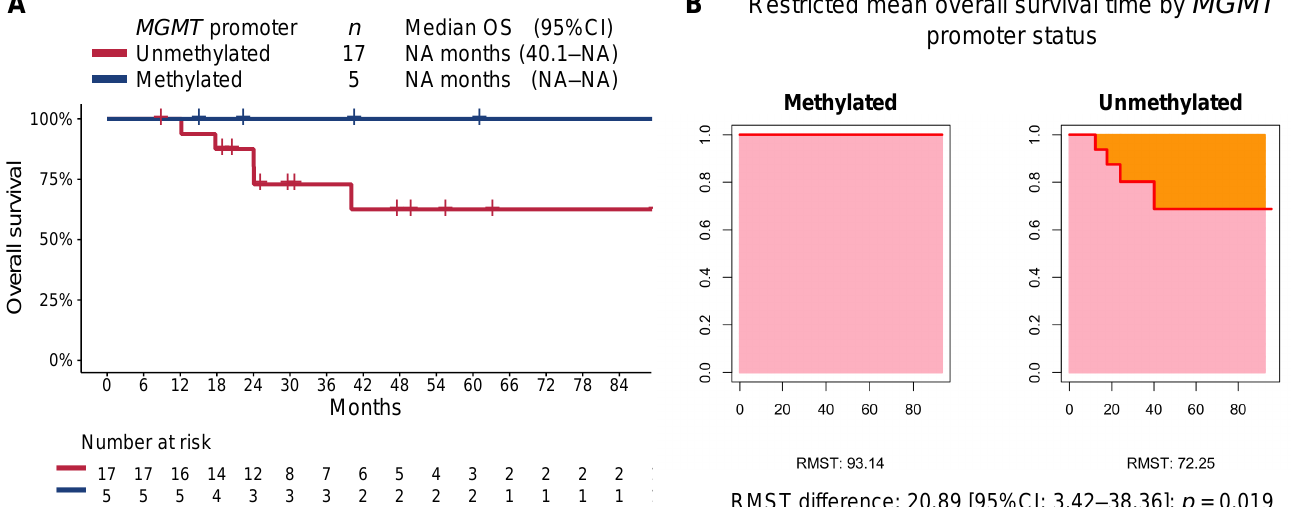
Figure 3. ( A ) Kaplan–Meier estimate of overall survival (OS) by MGMT-promoter methylation status, and ( B ) restricted mean progression-free survival time (RMST) by MGMT-promoter methylation status. Since patients with panNETs had longer PFS when compared to those with extra- pancreatic NETs (55.0 months [95%CI 27.5–NA] vs. 30.2 months [6.6–NA], respectively; RMST p = 0.016), we sought to correct for potential covariates and found that the MGMT- promoter status retained its association with progression-free survival (adjusted RMST difference: 37.89 [95%CI 3.63–72.16]; p = 0.03; Table